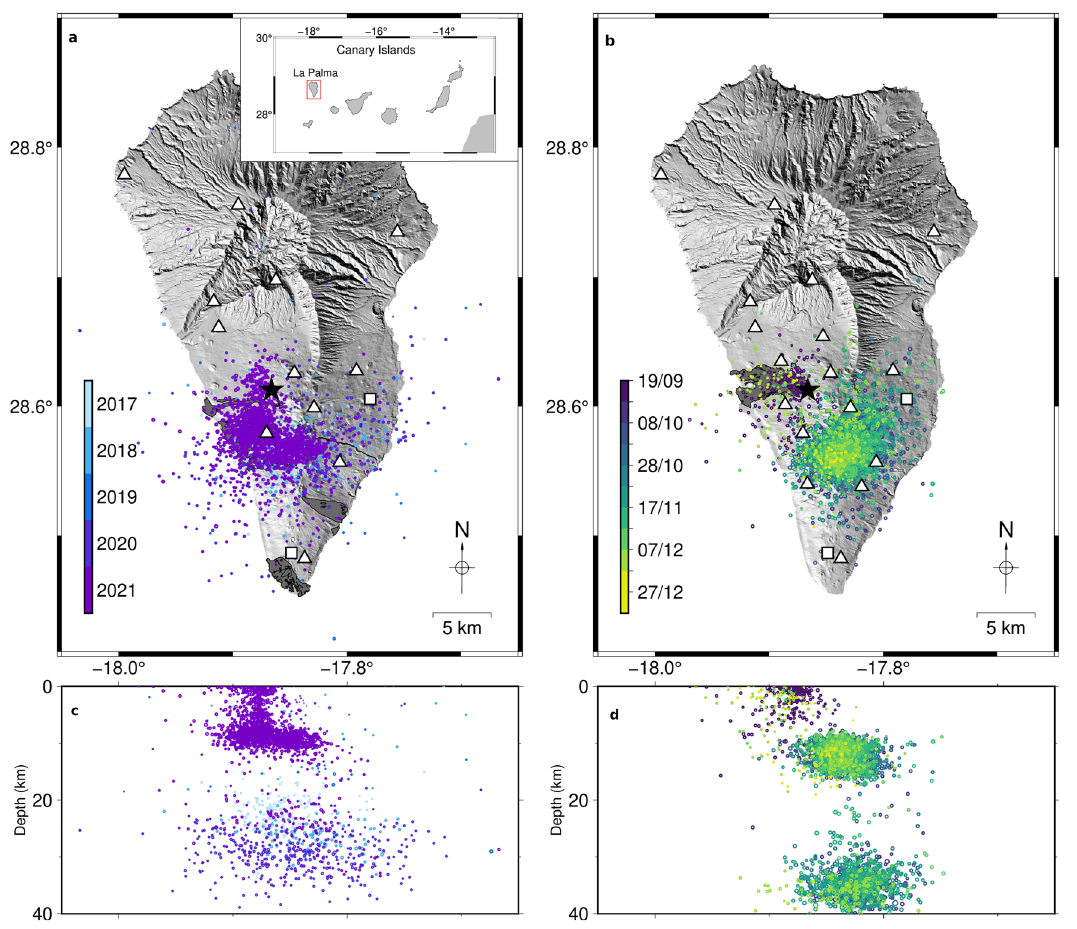
Fig. 1 | Seismotectonic settings of La Palma Island, Canary Islands, Spain. a, b Shaded-relief elevation model overlaid by the seismicity record at La Palma from the IGN catalogue (coloured dots) with seismic stations (triangles) and GNSS sta- tions(squares)usedinthisworkpriorto( a )andafter( b )eruptiononset.Lava fi elds